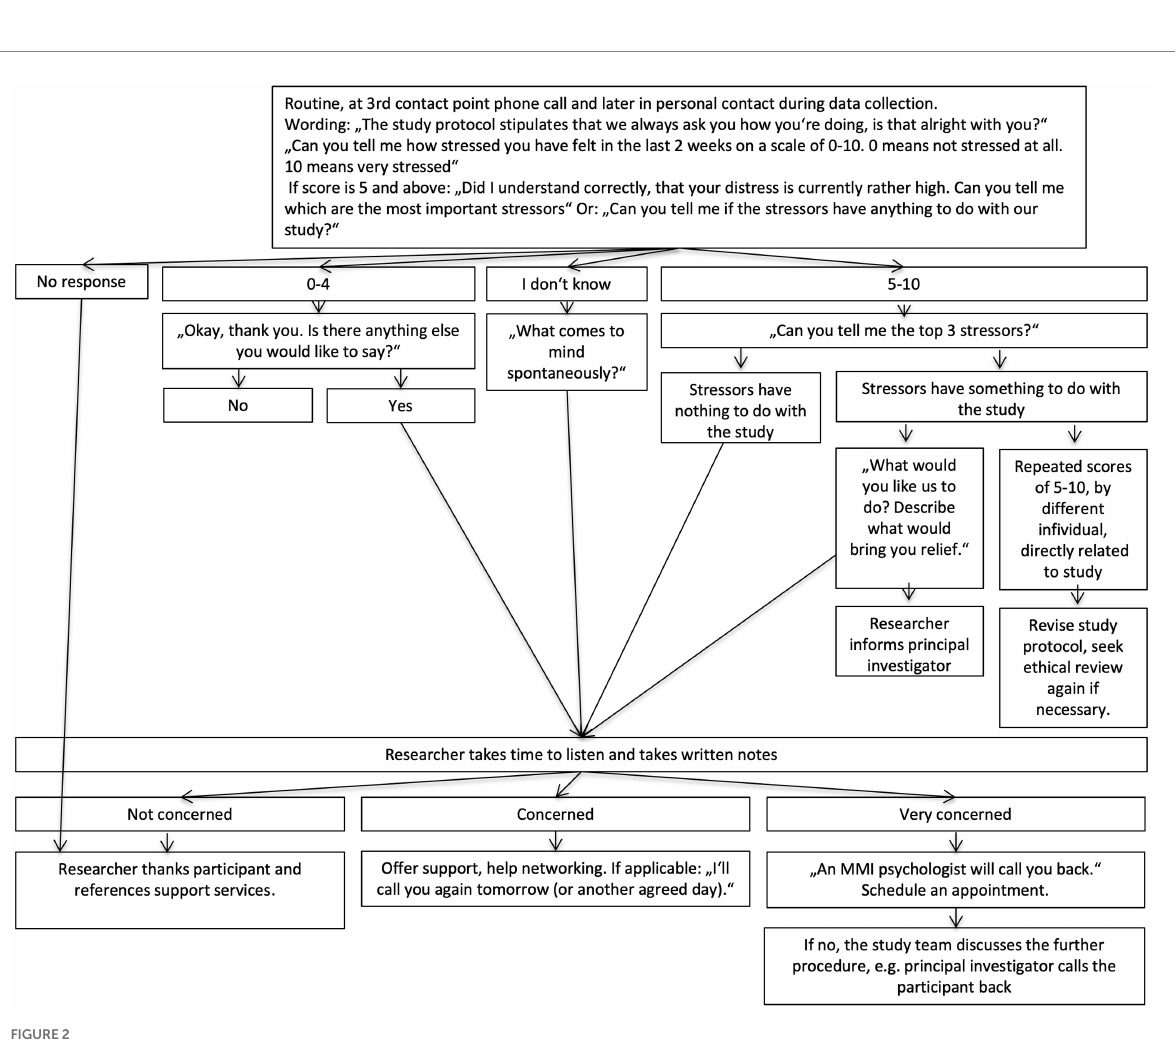
FIGURE 2 Algorithm to screen for distress.